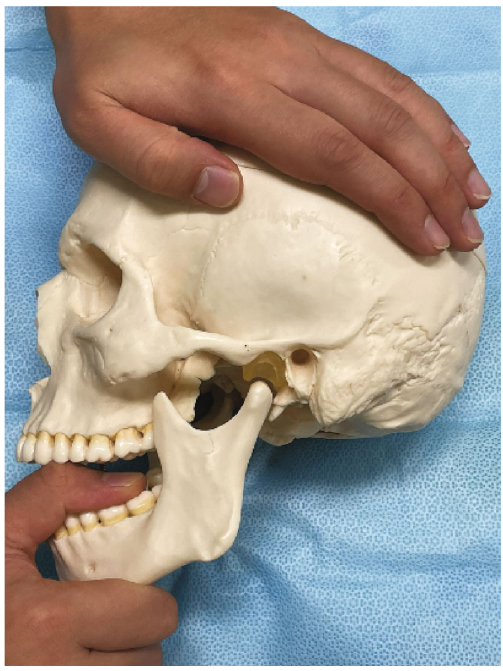
Figure 3: The technique of jaw